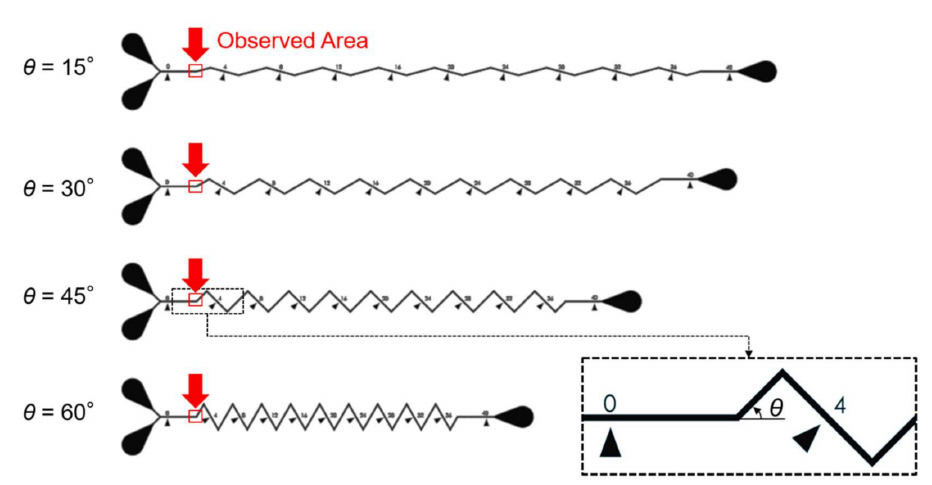
Figure 4. The design of the microfluidic chip and the chosen locations for machine